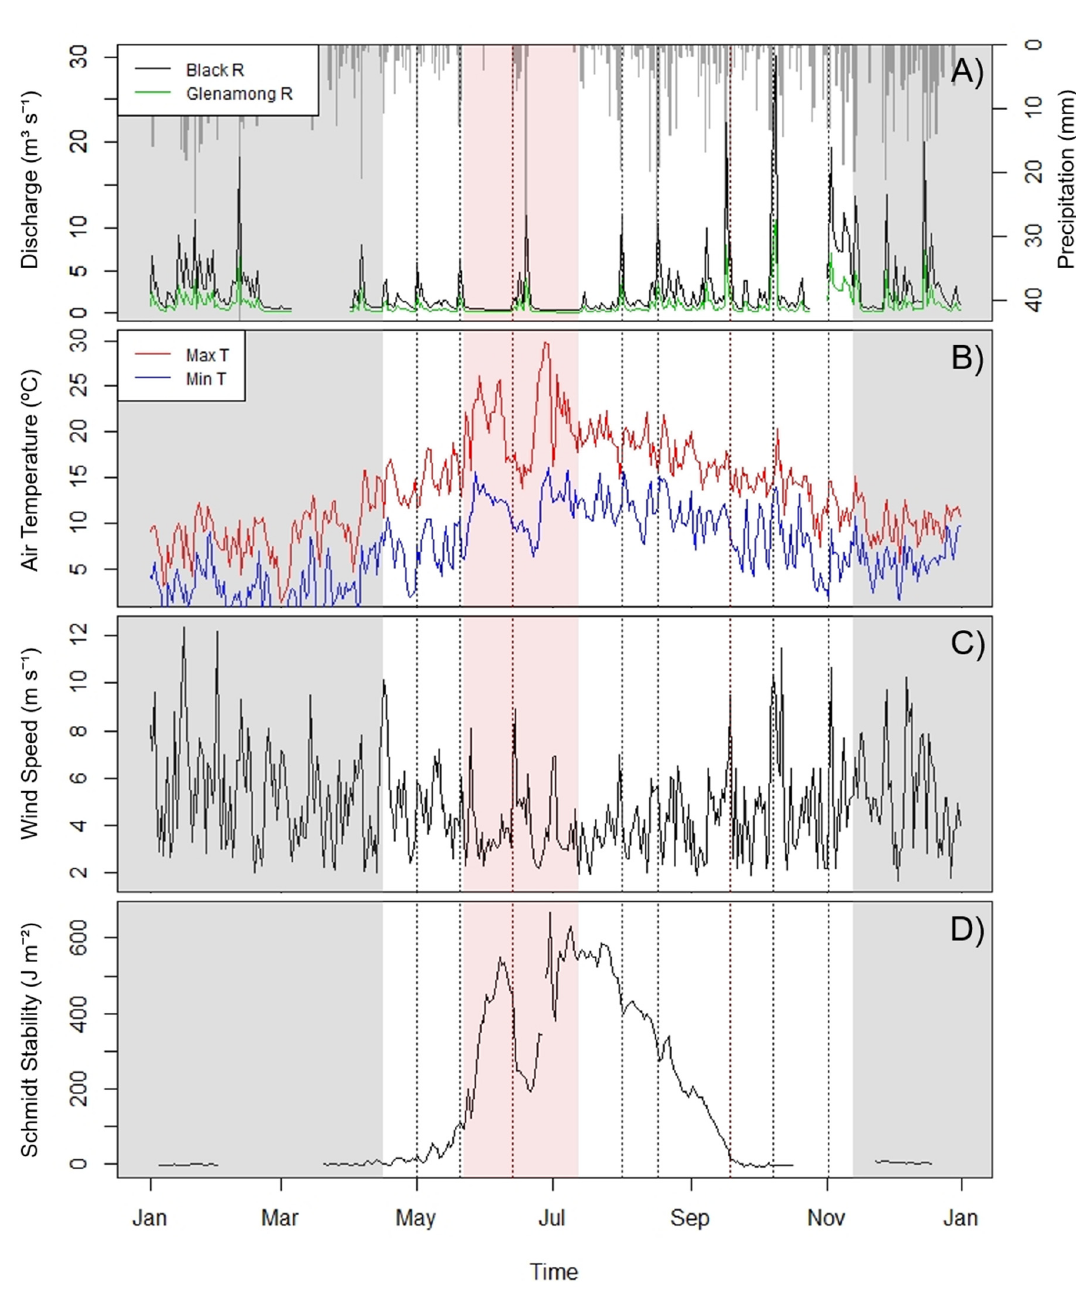
Figure 2. Environmental variables for the entire year of 2018: ( A ) the discharge of the inflow rivers and daily precipitation, ( B ) minimum and maximum daily air temperature, ( C ) wind speed, and ( D ) Schmidt stability. Shaded grey areas indicate dates outside the study period. Dotted vertical lines represent weather events. The pale red shaded area indicates the drought period.